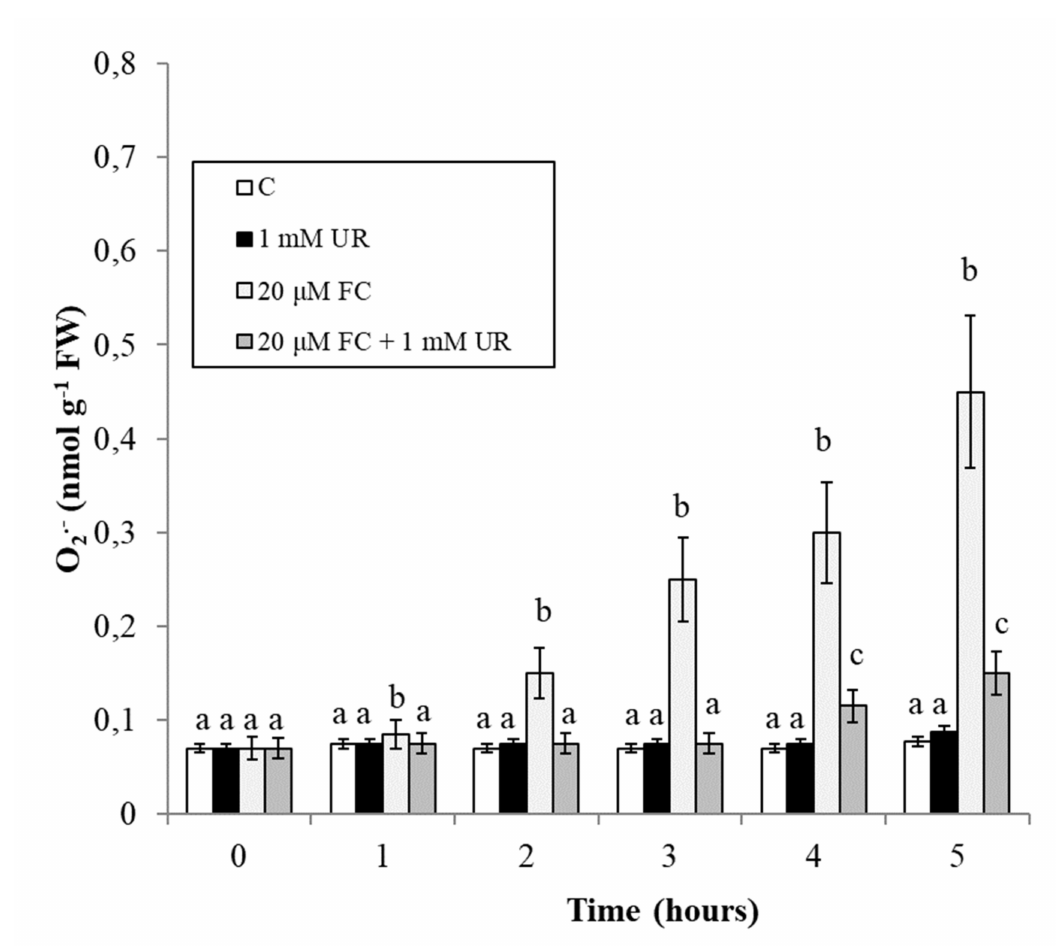
Figure 4. Effect of FC and urate on O 2 − accumulation in the culture medium. Means ± SD (n ≥ 9) are shown. Different letters show significant differences among treatments at each time (Tukey HSD test, p ≤